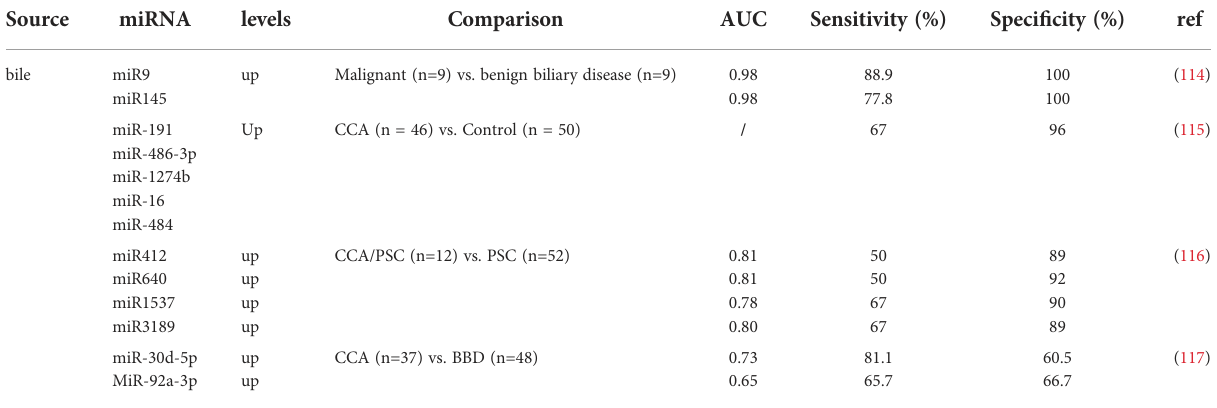
TABLE 2 Bile miRNAs with potential diagnostic value for